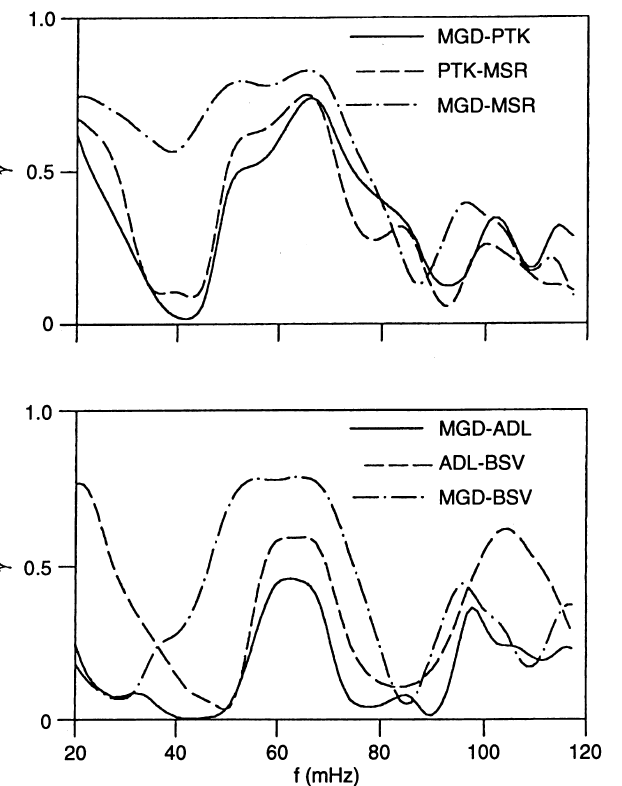
Fig. 10. Coherency coe(cid:129)cients c (cid:133) f (cid:134) of H -components between di(cid:128)erent pairs of stations MGD, PTK, MSR for event 2. The bottom panel is the same for the stations MGD, ADL, and BSV